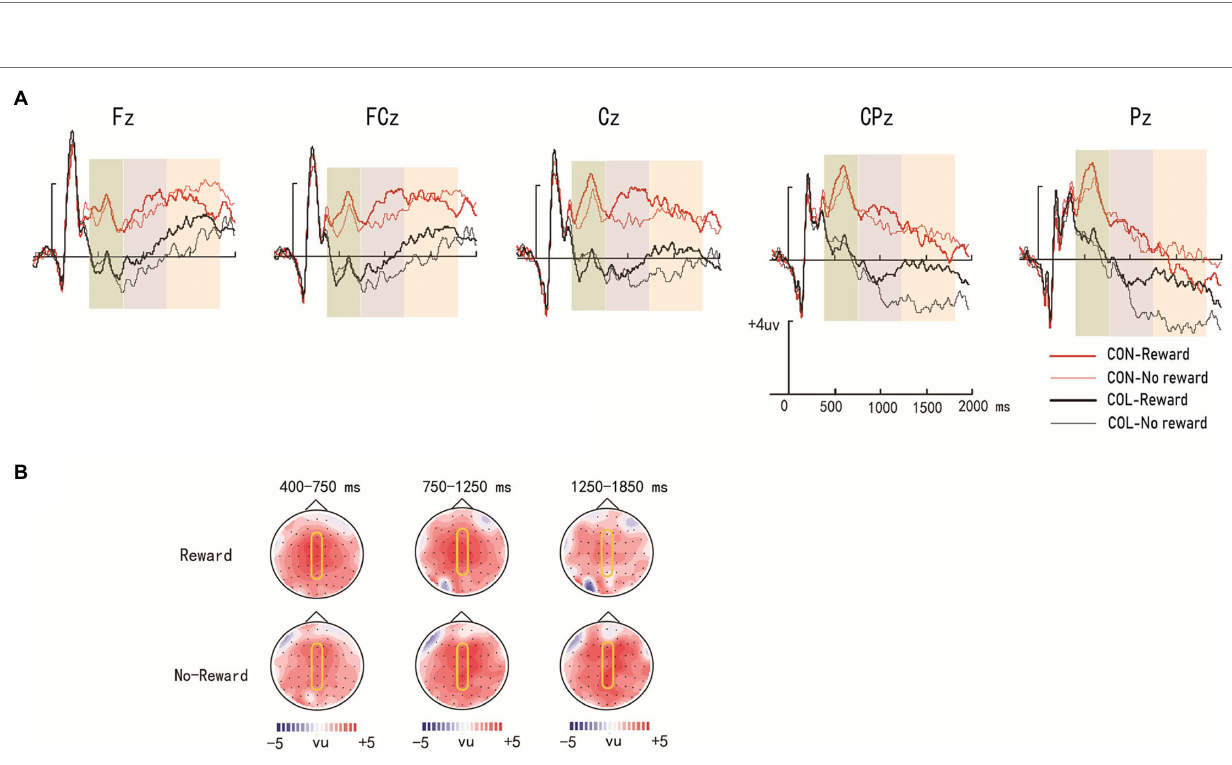
FIGURE 3 | Amplitude distribution and topographic maps of event-related potentials (ERPs) during encoding. (A) Amplitude distribution of ERP measurements in relation to reward effects and encoding task effects. (B) Topographic maps of ERPs on the effect of encoding task on the object items encoded under reward and nonreward